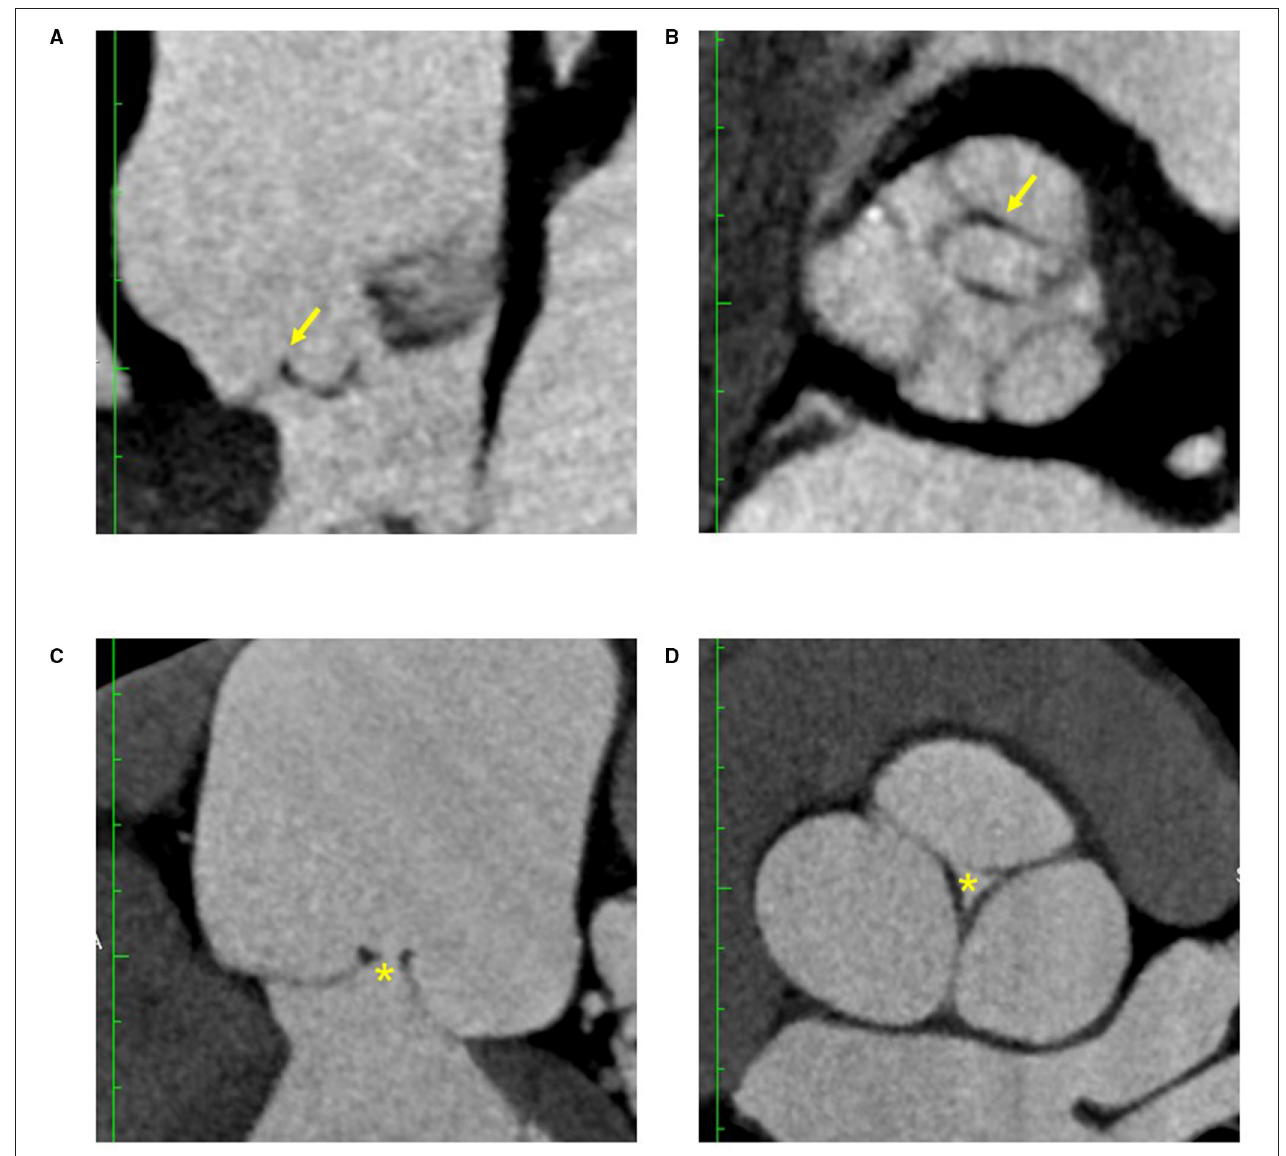
FIGURE 4 | CT features of AR with eccentric jet and central jet. Bent leaflet belly indicated by arrows were both identified in long axis (A) and short axis (B) of reconstructed CT images in AR with eccentric jet. Loss of coaptation indicated by asterisks were both identified in long axis (C) and short axis (D) of the reconstructed CT images in AR with central jet. AR, aortic